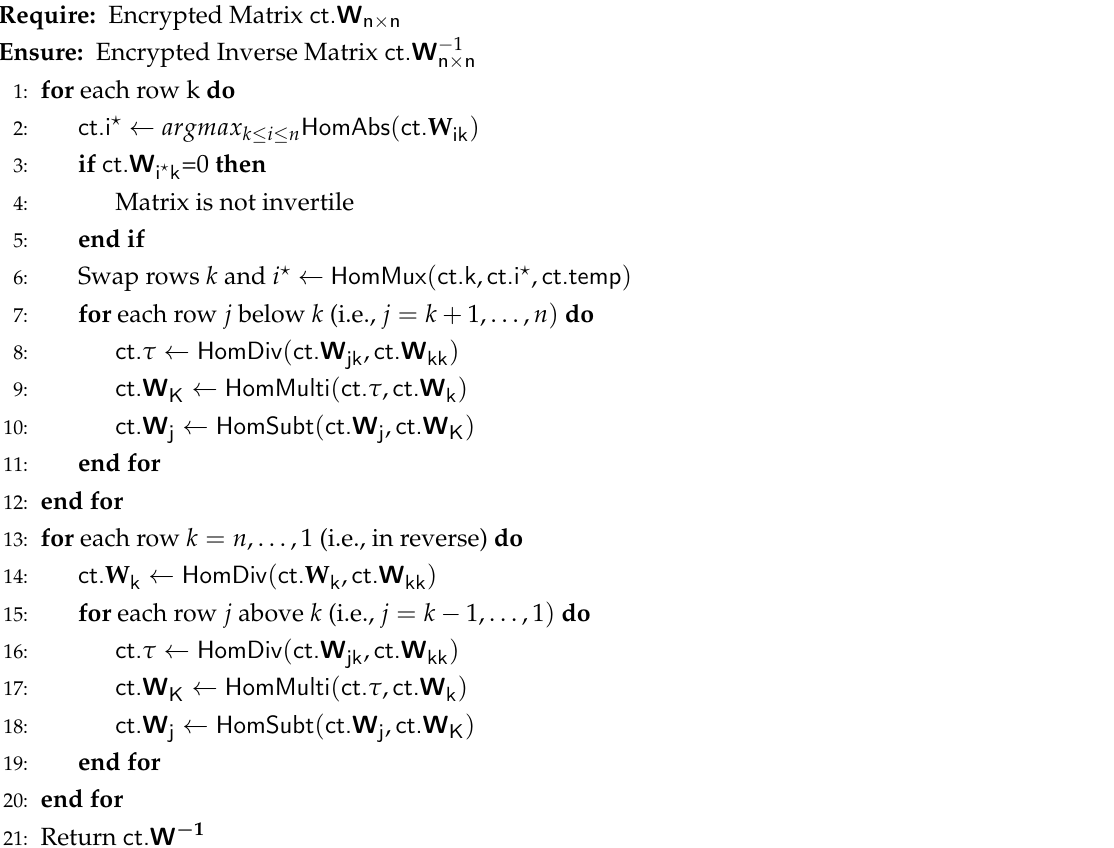
Algorithm 6 ct. W − 1 = HomGJ ( ct. W ) : Homomorphic Matrix Inversion using Gauss- Jordan